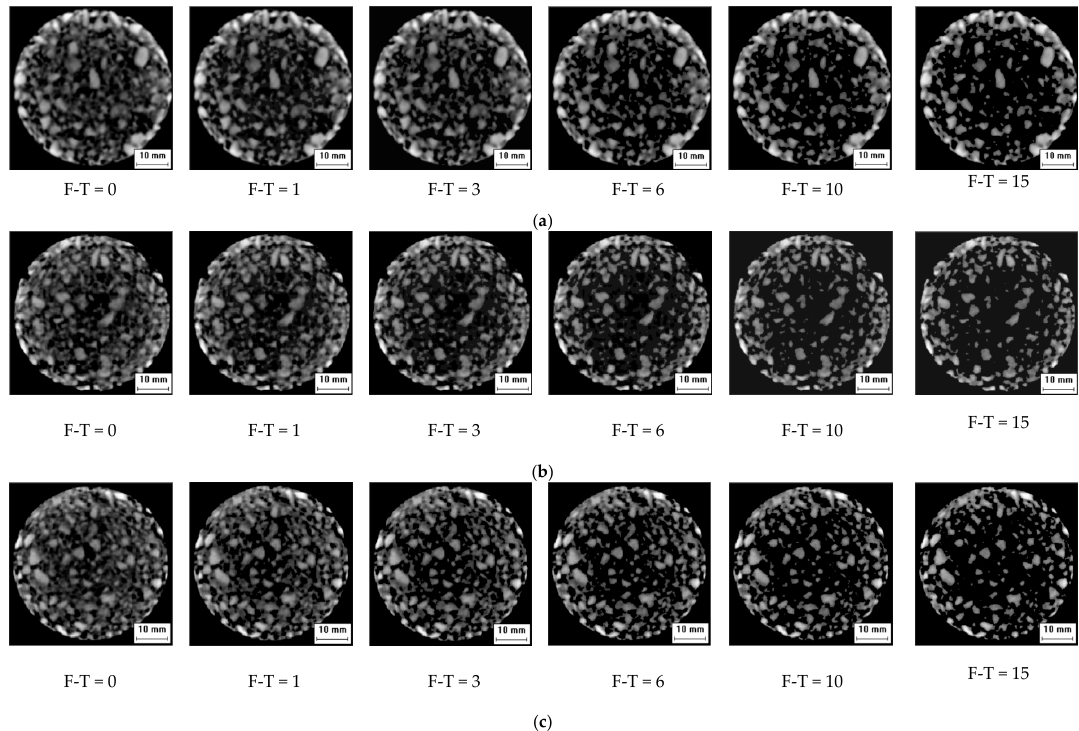
Figure 3. Digital image processing technology. ( a ) 1st cross section gray image, ( b ) 2nd cross section gray image, ( c ) 3rd cross section gray image.